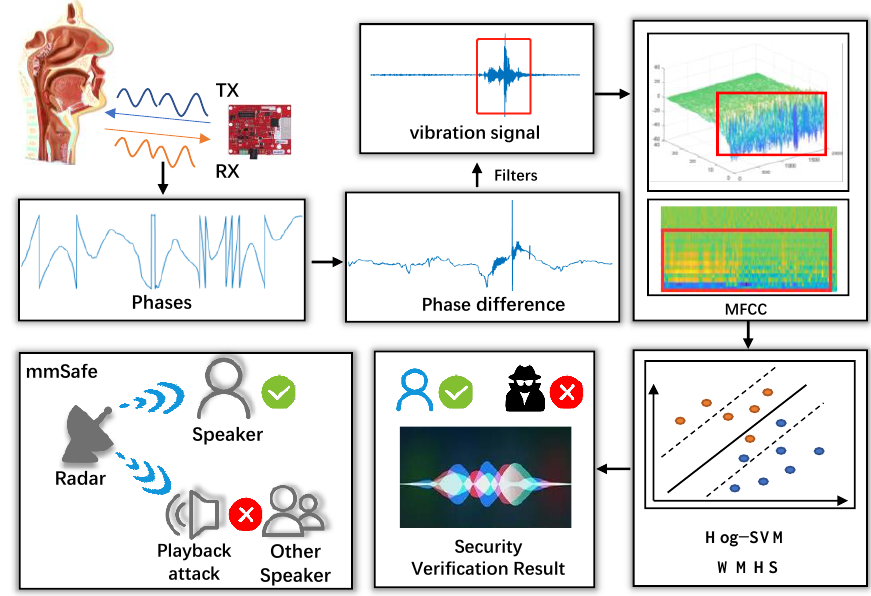
Figure 1. mmSafe system workflow.